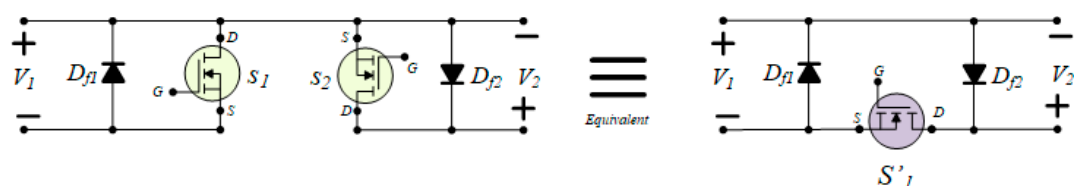
Figure 3. Synchronous switches with a common drain-source node (type “DS: I-II type”, [3]) and its equivalent single switch topology (“Inverted IISS:I-IISS”, [3]).